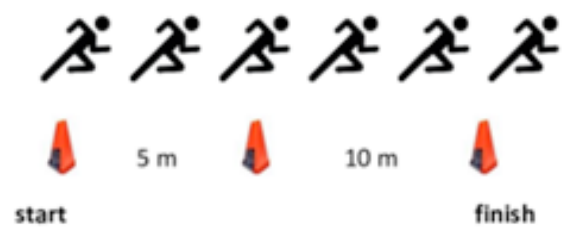
Figure 1. 0-15-m sprint test design Asymmetry test: In the jump test